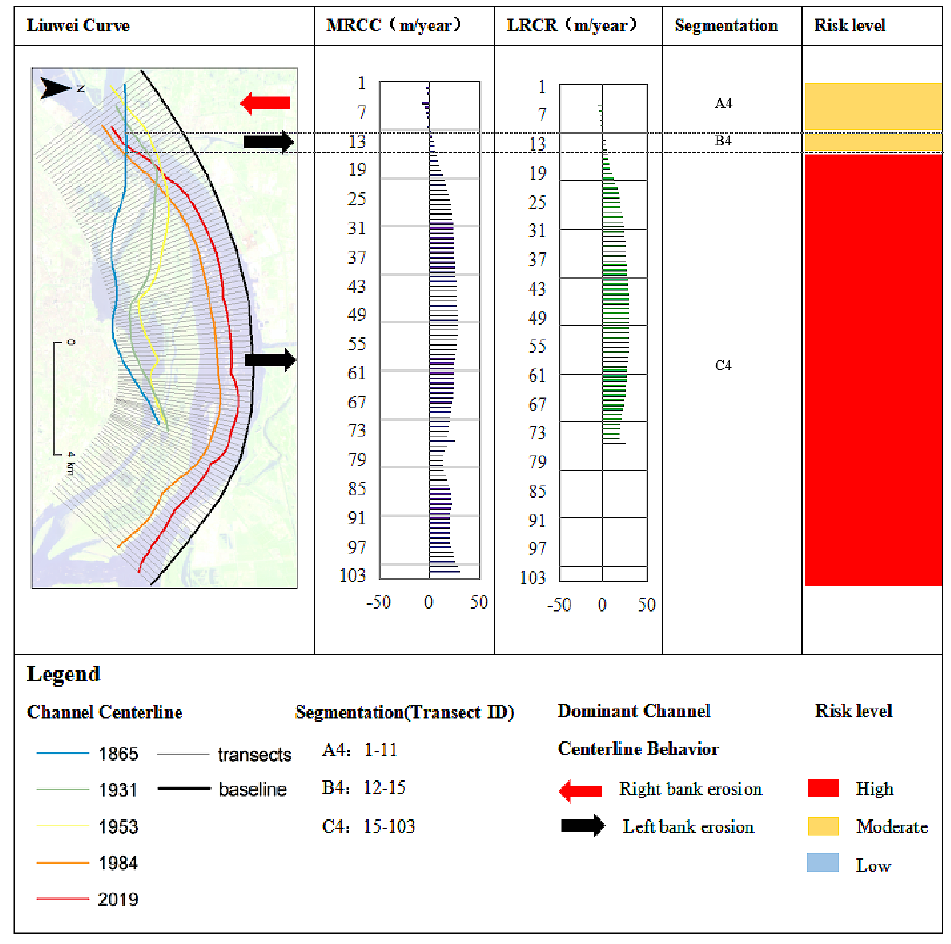
Figure 8. The Migration Rate of Channel Centerline, Linear Regression Change Rate, and erosion risk identification on Liuwei Curve.